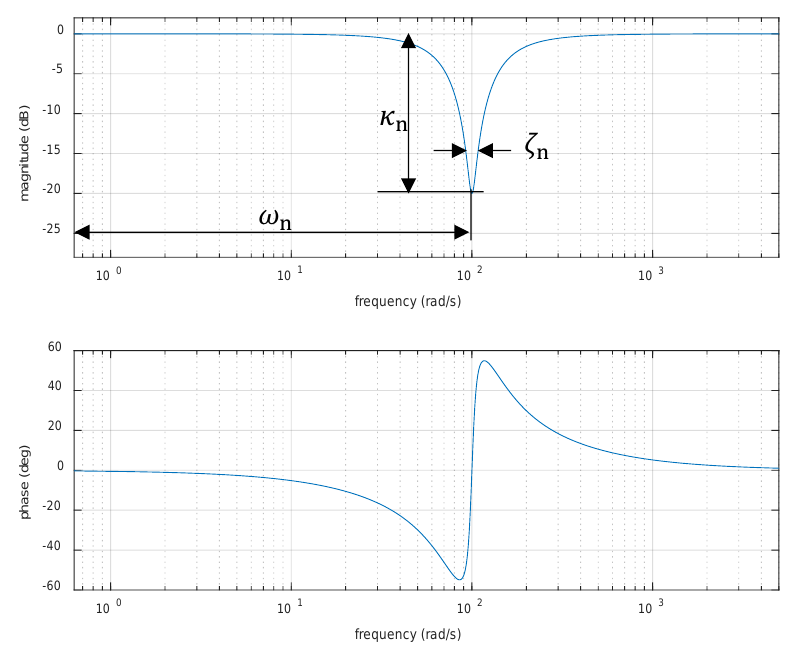
Figure 3. The Bode plot of the notch filter as ω n = 100 (rad / s), ζ n = 0.05, and κ n = 20 (dB). The outer loop is the position loop, which contains the velocity loop, the transmission model and the position controller. The position controller is a proportional gain and is represented as K pp .